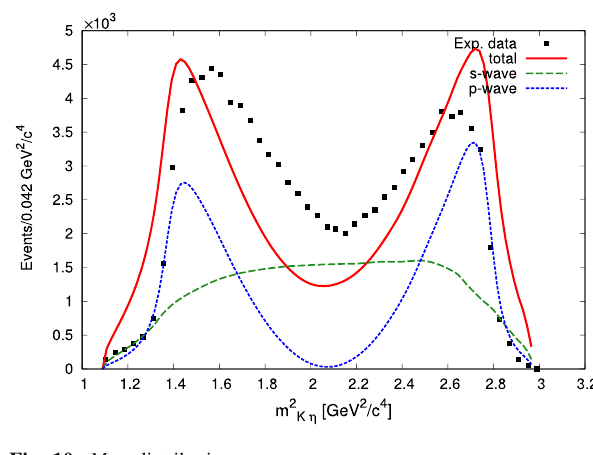
Fig. 7 M K π distribution. Individual contributions. The total s -wave contains the tree level, the a 0 ( 980 ) and the κ rescattering terms